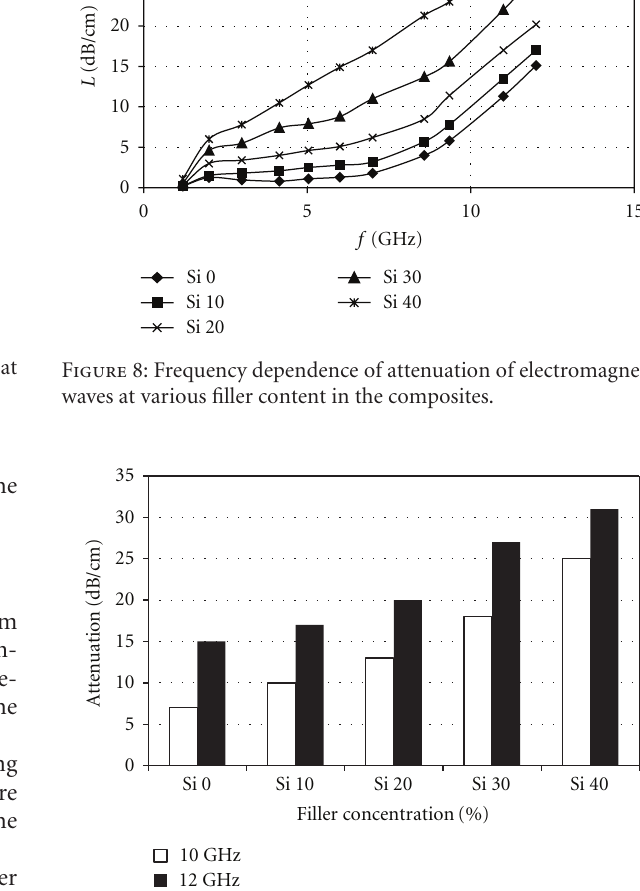
Figure 9: Dependence of attenuation of electromagnetic waves on the concentration of the introduced